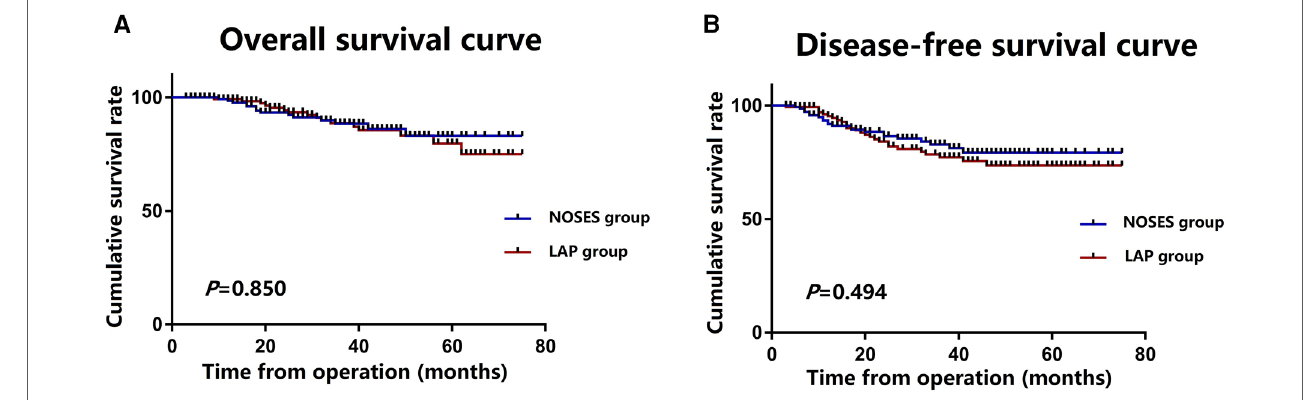
FIGURE 3 Survival outcomes for the NOSES and LAP groups; ( A ) overall survival in the NOSES and LAP groups; ( B ) disease-free survival in the NOSES and LAP